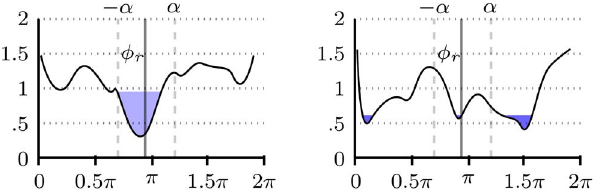
{ w conf , w est z i i Figure 8. Nearest neighbors in an a radius. Left, all k nearest neighbors are in an a radius, by contrast most of the k nearest neighbors on the right figure are spread over the interval ½ 0,2 p ) .